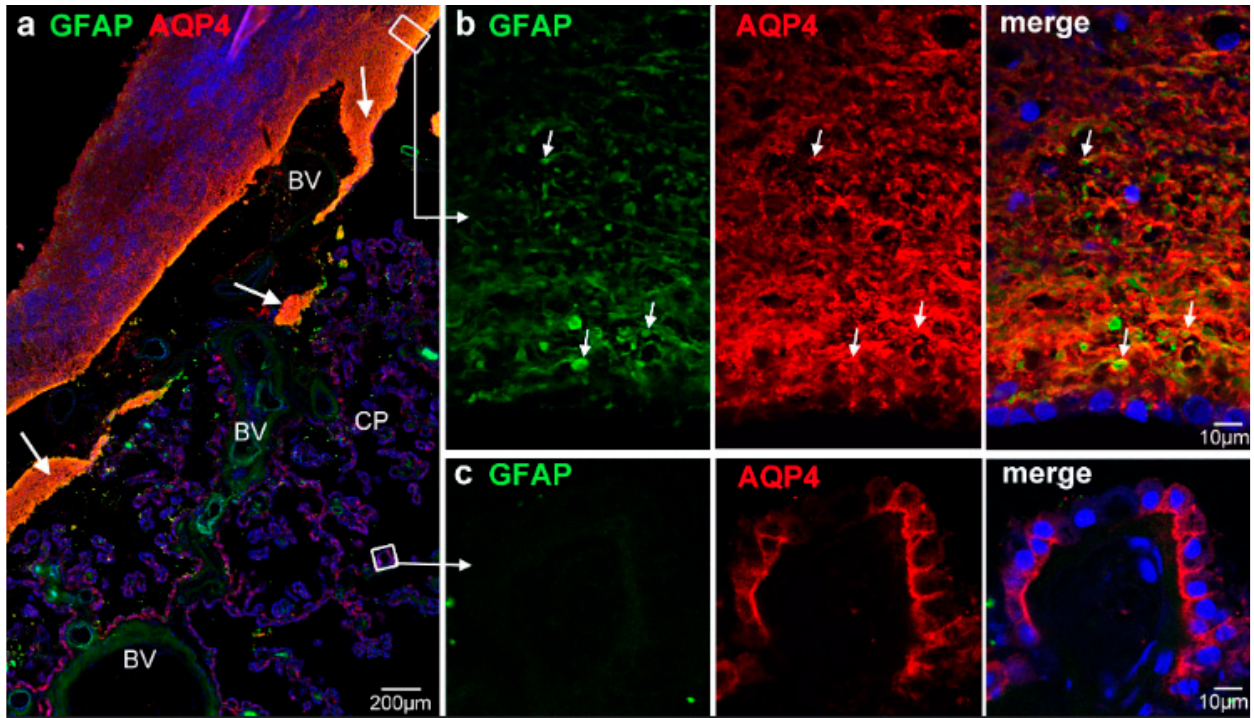
Figure 2. Subependymal tissue in the transitional zone is formed by astrocytes. ( a ) At low magnification, GFAP immunoreactivity largely overlaps with AQP4 stain under the transitional ependyma (large arrows). ( b ). Detailed view from the ependymal/subependymal region indicated by the white box shows a dense meshwork of GFAP-positive processes and strong AQP4 immunoreactivity. The GFAP processes are often surrounded or associated with AQP4 staining (small arrows). The surface ependymal cells are only weakly positive for GFAP. ( c ) GFAP stain is completely lacking in AQP4-positive CP epithelial cells. Nuclei are stained with DRAQ5. BV, blood vessels. To further define this structural change from the ependyma to the CP, we marked the course of the CP epithelium with laminin. The CP epithelial cells are consistently connected to a basal lamina which disappears at the point where the ependymal cells start. The laminin expression underneath AQP4-positive and AQP4-negative CP epithelial